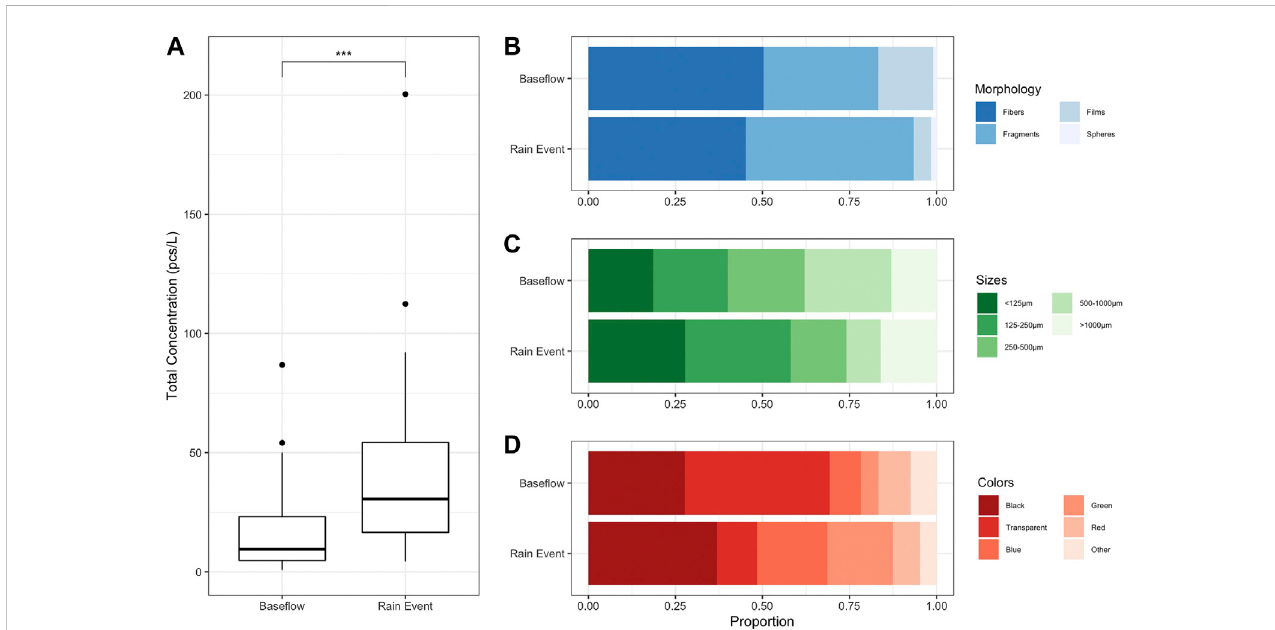
FIGURE 3 (A) Boxplots ofmicroplastic concentrations instormwatercollectedduring base fl owand rain events.*represents asigni fi cantdifference with p < 0.001. Right side shows the average percent composition of microplastics in different morphological categories (B) , size classes (C) , and colors (D) in stormwater during base fl ow and rain